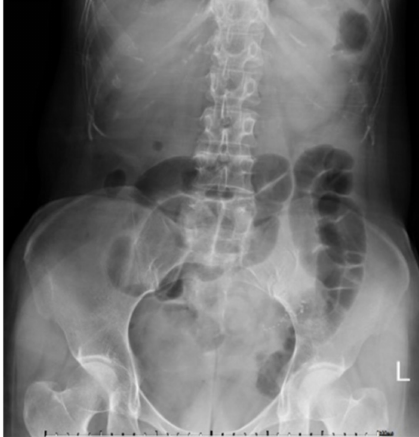
Figure 1. Plain abdominal radiograph revealed gaseous dilatation of the small